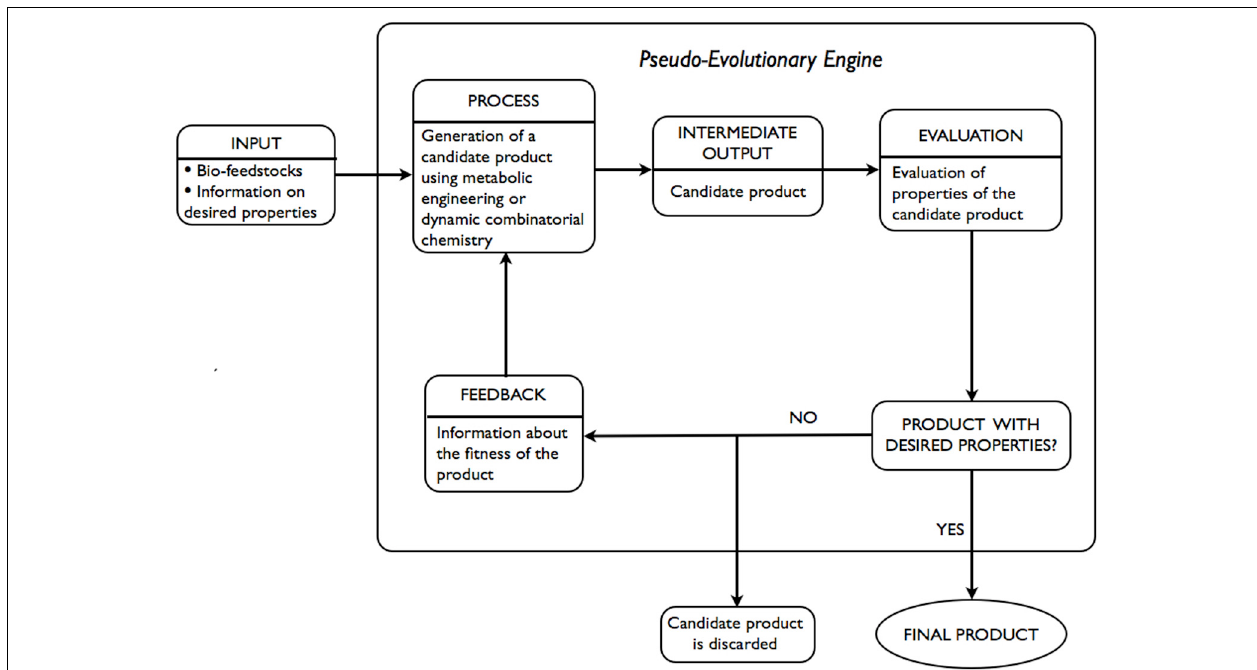
FIGURE 3 | Schematic representation of evolution-based